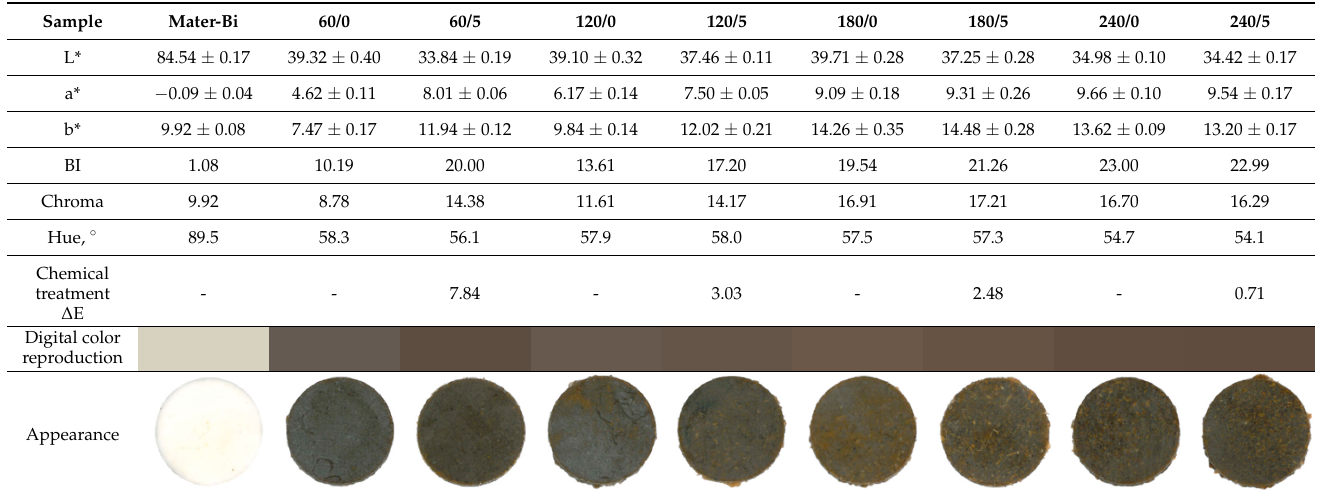
Table 4. The color parameters or unfilled Mater-Bi and prepared Mater-Bi/BSG composites.